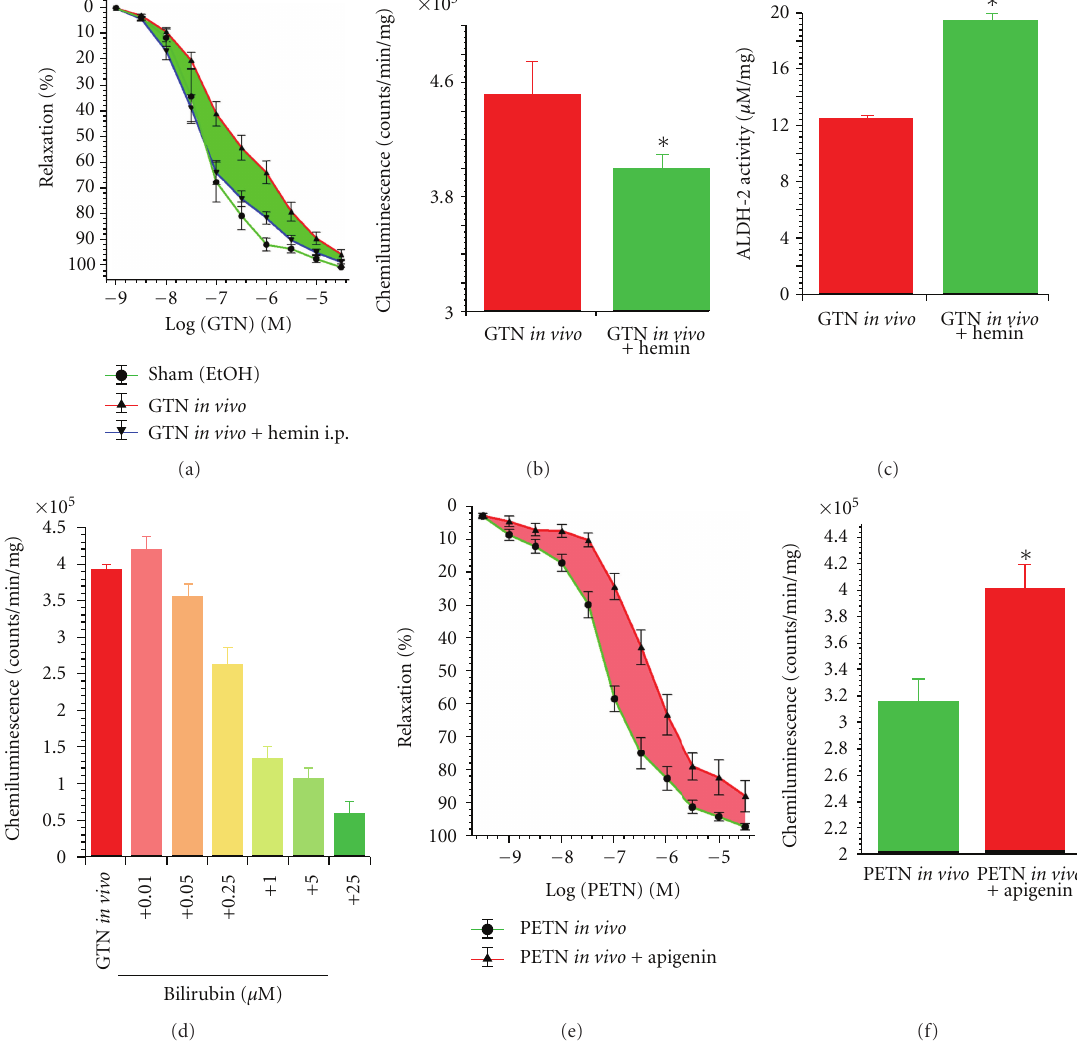
Figure 1: E ff ects of the HO-1 inducer hemin on GTN-induced tolerance and e ff ects of the HO-1 suppressor apigenin on PETN side e ff ects. Hemin (25mg/kg) was administrated by single i.p. injection on day 3 of GTN treatment (6.6 μ g/kg/min for 4days via s.c. infusion) and markedly improved vascular GTN responsiveness (see area between curves) as demonstrated by isometric tension studies (a), a significant decrease in mitochondrial ROS formation (b), and improvement of mitochondrial ALDH-2 activity (c). E ff ects of bolus bilirubin on ROS formation in isolated heart mitochondria from GTN in vivo treated rats were determined by L-012 (100 μ M) ECL in the presence of 2.5 mM succinate and bilirubin (0–25 μ M) (d). Apigenin (10mg/kg/d) was coinfused over 4d together with PETN (10.5 μ g/kg/min for 4 days via s.c. infusion). Apigenin cotreatment decreased PETN vasodilator potency (see area between curves) and induced a tolerance-like right shift in the PETN concentration-relaxation-curve (E). This observation was accompanied by increased mitochondrial ROS formation (F). Data are mean ± SEM of n = 8–12 (a), 40 (b), 6–18 (c), 4–6 (d), 9–11 (e), and 28–43 (f) independent experiments. ∗ P < 0 . 05 versus GTN or PETN treatment. Modified from